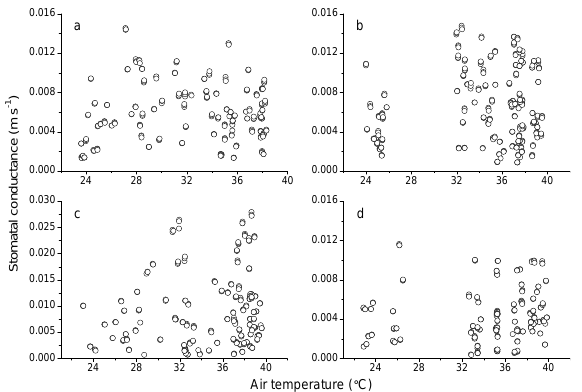
Fig. 3. Response of stomatal conductance to photosynthetically ac- tive radiation at the four levels in the maize canopy on DOY 130 (a) , DOY 162 (b) , DOY 195 (c) , and DOY 229 (d) , respectively. F04 1